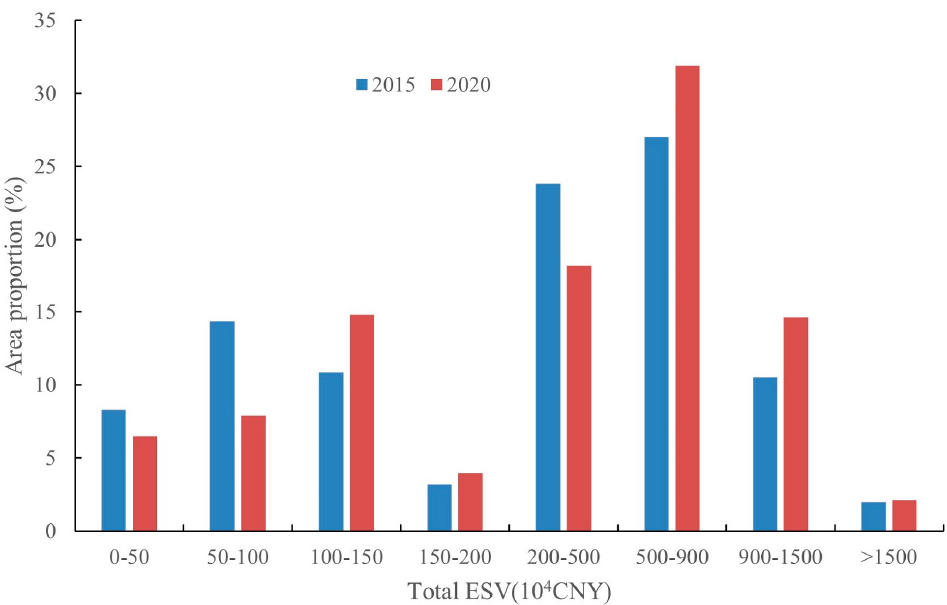
Figure 3. Area proportion total ESV of study area at grid scale in 2015 and 2020.